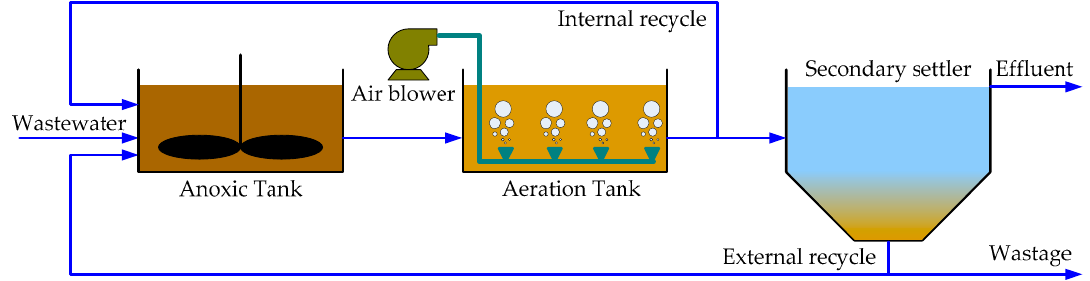
Figure 1. Typical biological (or biochemical) ASP to treat wastewater. ASP: Activated Sludge